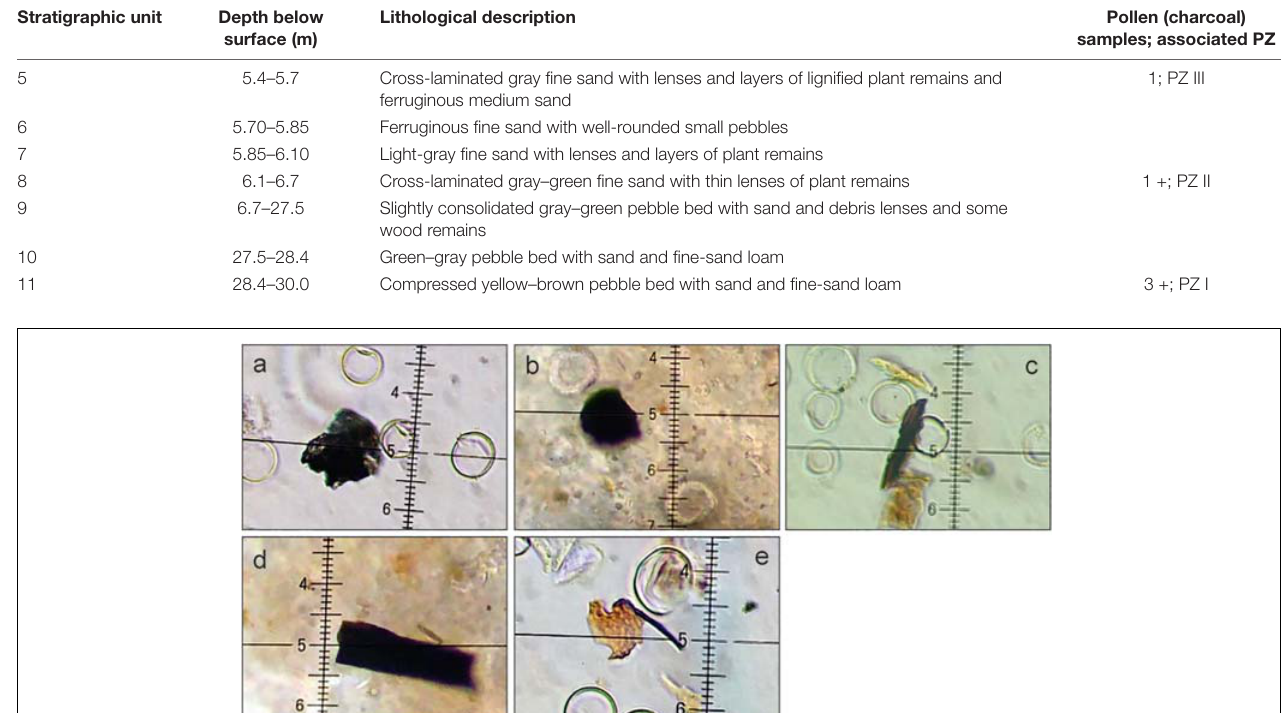
pollen and higher percentages of Botryococcus remains and cysts of Volvocales. PZ VI ( ∼ 1.1–0.0 m) is dominated by pollen of Betula sect. Nanae , A. fruticosa , Ericales, Poaceae, Artemisia , and